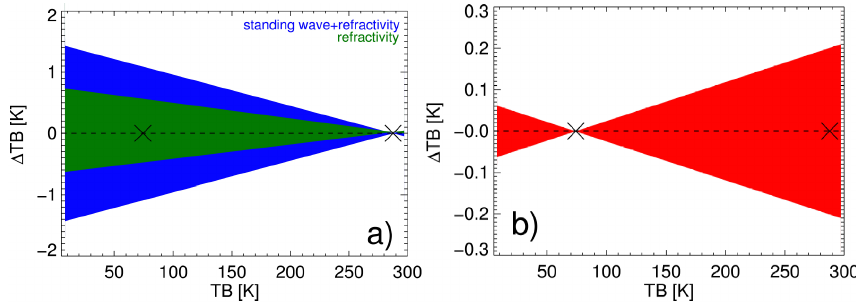
Fig. 4. (a) Uncertainty in derived T b from uncertainties at the cold calibration point, blue: area of uncertainty resulting from the uncertainty for the refractive index of the LN 2 surface ( n =1.20 ± 0.03 (Benson et al., 1983)), green: area of uncertainty for a single calibration due to resonances between the LN 2 surface and the receiver. (b) Uncertainty in derived T b from uncertainties at the hot calibration point, red: area of uncertainty from errors in the in-situ temperature measurement of the internal ambient target ( 1T H = ± 0.2K), X: cold and hot calibration point. Note that the y axes of the two subplots have different limits.